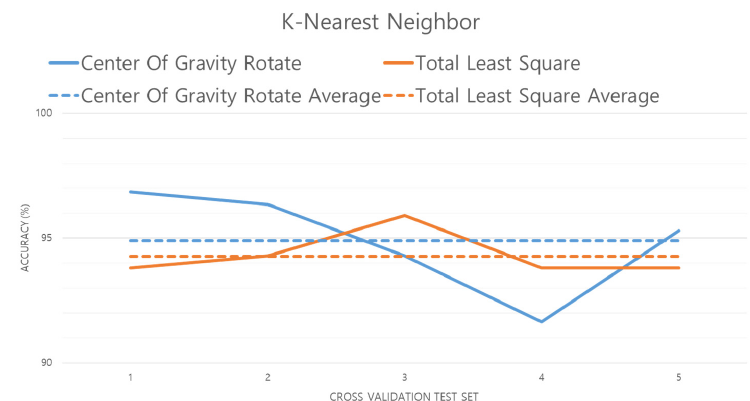
Figure 19. Performance evaluation of K-NN algorithm.